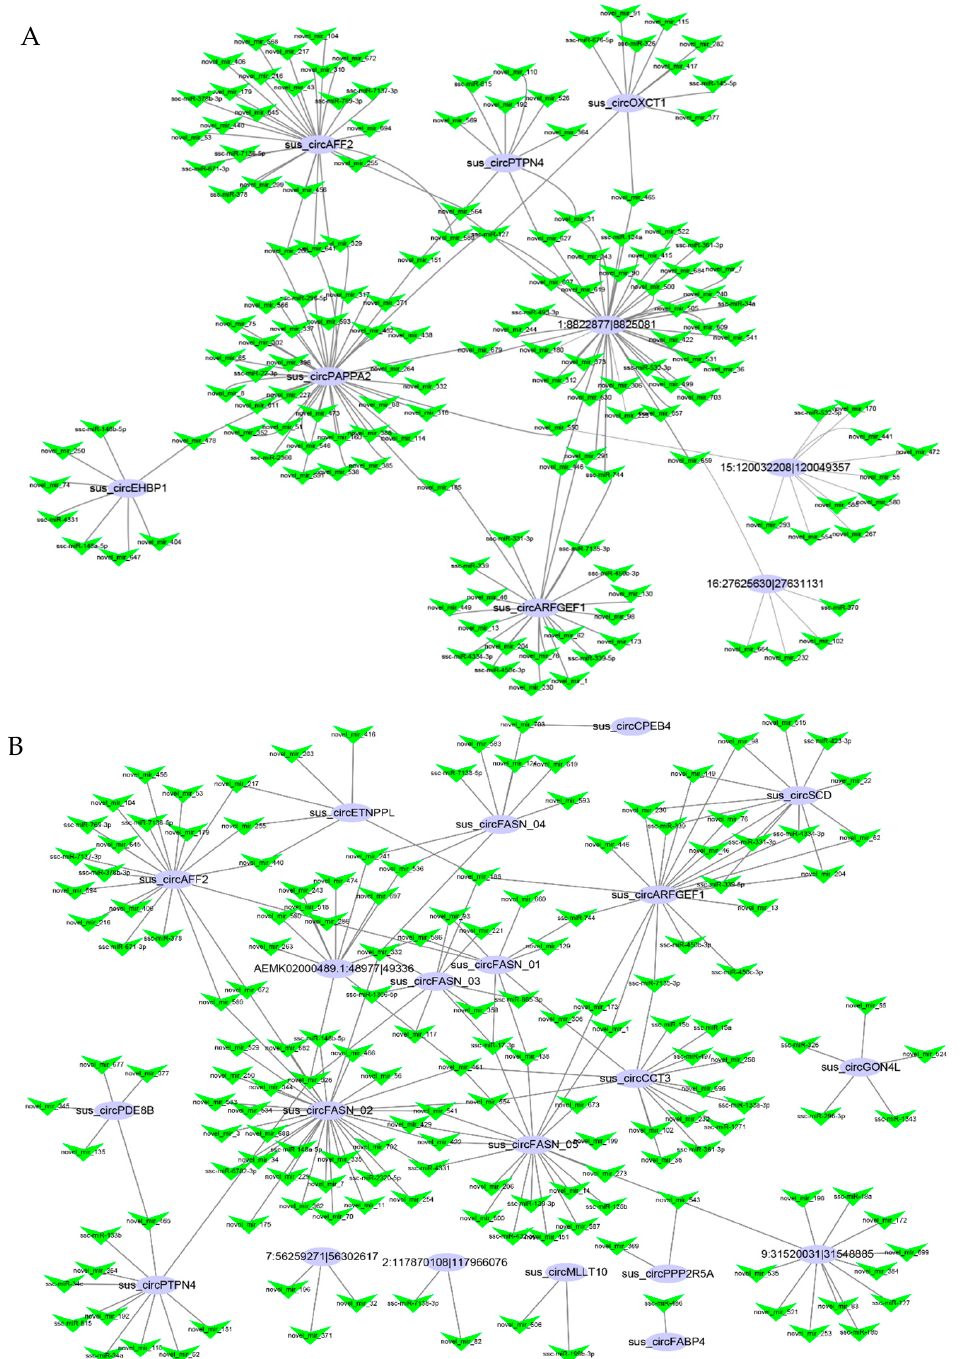
Figure 4. Prediction of circRNA target miRNAs. ( A ) CircRNA–miRNA network map of predicted backfat targets. ( B ) CircRNA–miRNA network map of predicted abdominal fat targets. The purple circles represent circRNAs, the green V shapes represent miRNAs and the straight line represents the interaction.